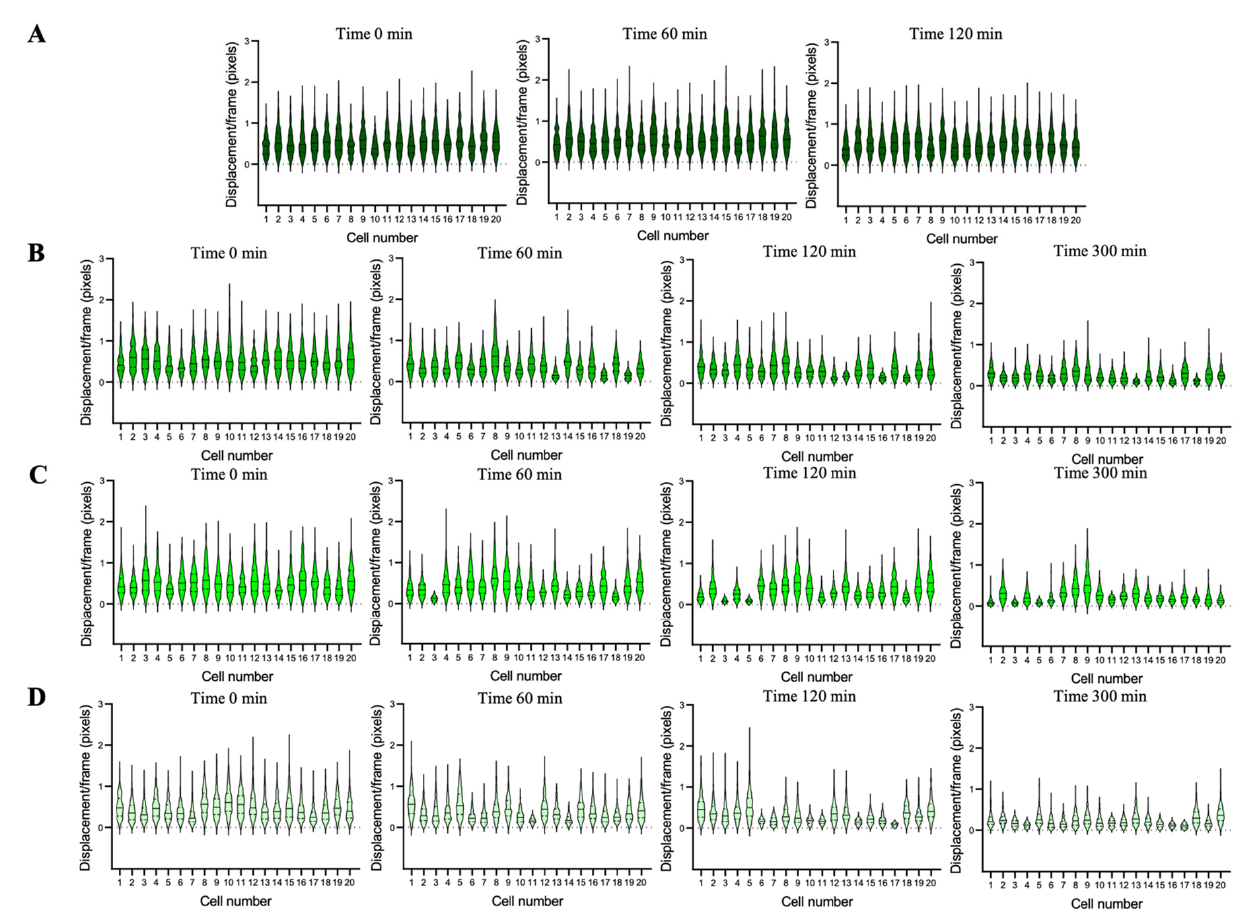
Figure 15. The displacement distribution for 20 single cells of C. albicans DSY1024 strain displayed in violin plots during ( A ) 2 h of growth in a YPD medium (control) and during 5 h of treatment with the antifungal fluconazole at ( B ) 0.5 µg/mL, ( C ) 1 µg/mL, and ( D ) 100 µg/mL.